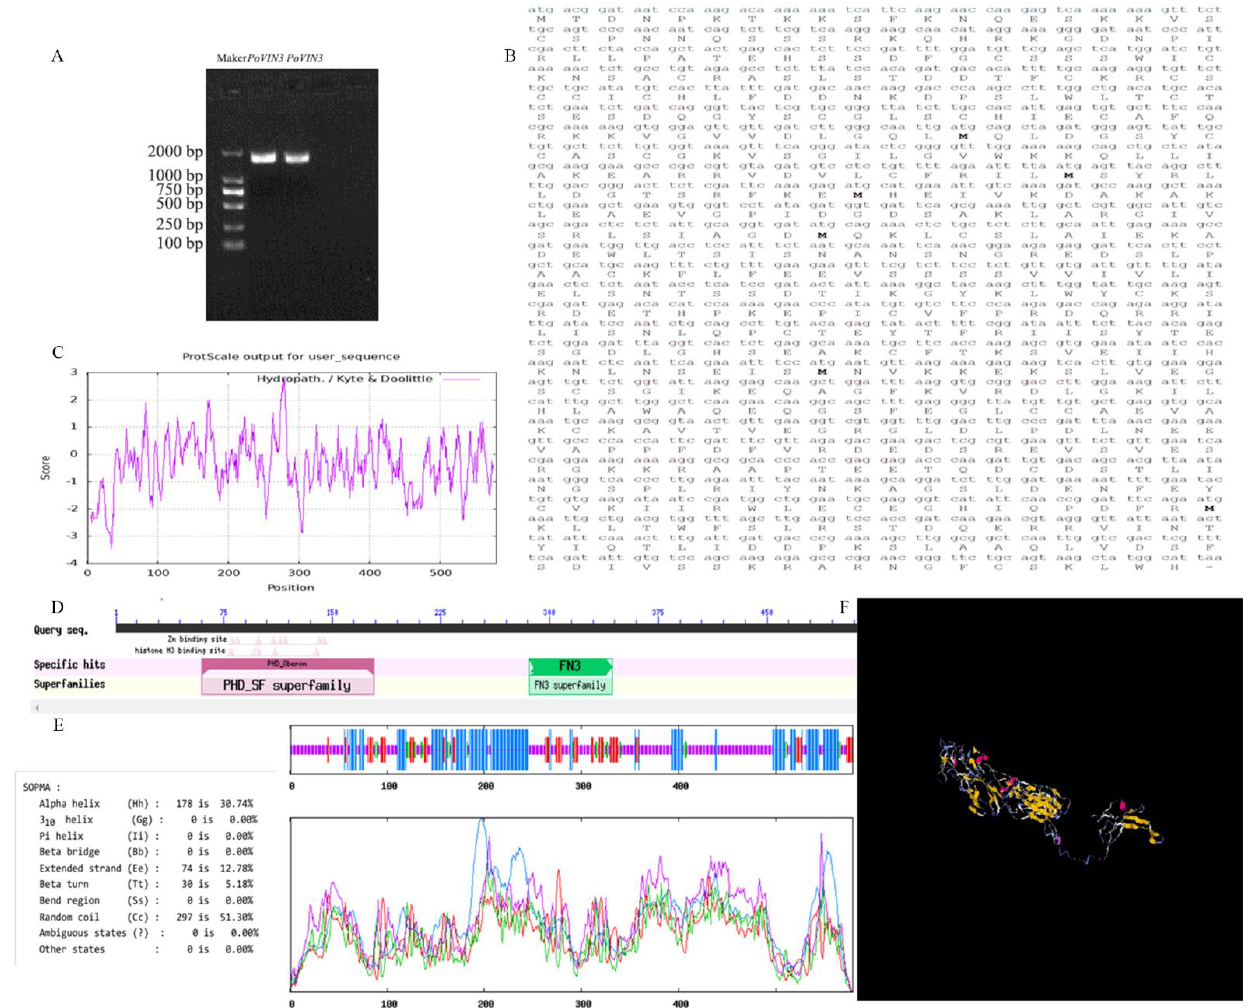
Figure 1. Cloning and bioinformatics analysis of PoVIN3 . ( A ) PCR amplified product of PoVIN3 , and M means DNA maker DL2000. ( B ) Nucleotide sequence and its encoded amino acid sequence. ( C ) Hydrophilic analysis of PoVIN3 − encoded protein. ( D ) Analysis of conserved domain of PoVIN3 . ( E ) Secondary structure prediction of PoVIN3 − encoded protein. ( F ). Tertiary structure prediction of PoVIN3 − encoded protein.